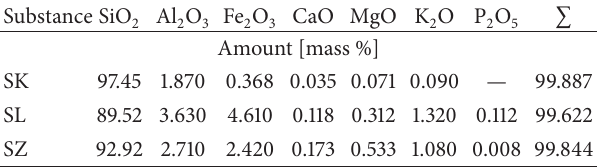
Table 2: XRF chemical composition of tested